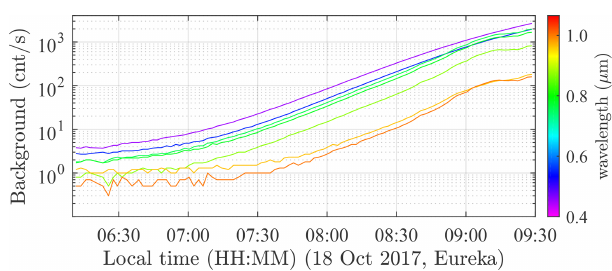
Figure 21. Sky brightness increase in the morning at Eureka for seven standard channels. The blue part of the spectrum is